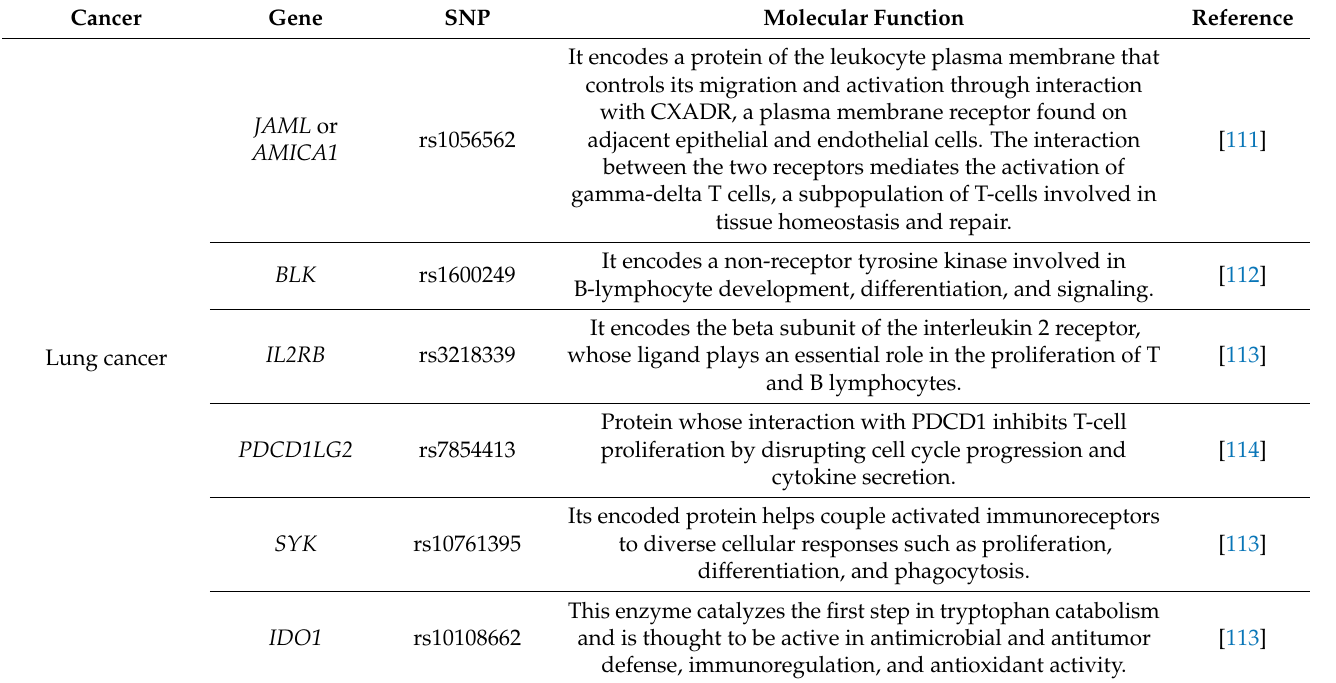
Table 1. Summary of genes implicated in cancer and metabolism, infection, or the immune system.